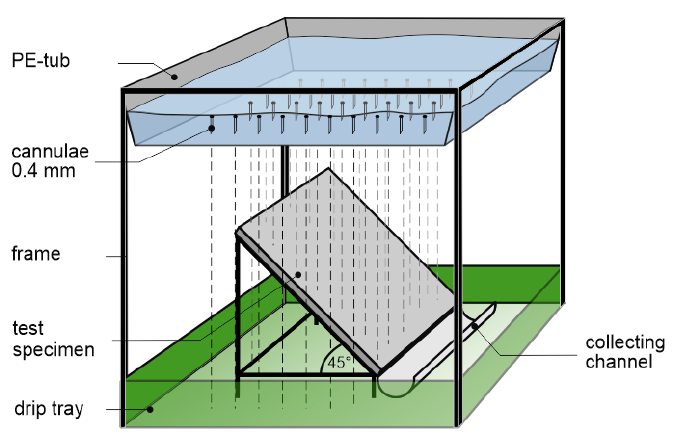
Figure 7. Schematic presentation of the laboratory irrigation stand.